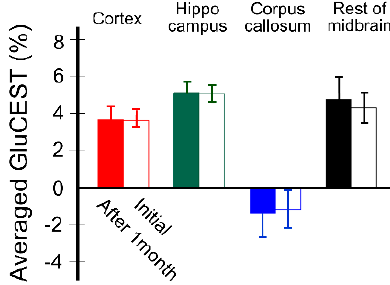
Figure 4. Quantitative values of GluCEST between two time points (from initial scan to one month after) using the same rats ( n = 5) for signal stability evaluation. The bars in each time point represent averaged values between both hemispheres, and the error bars represent standard deviations.